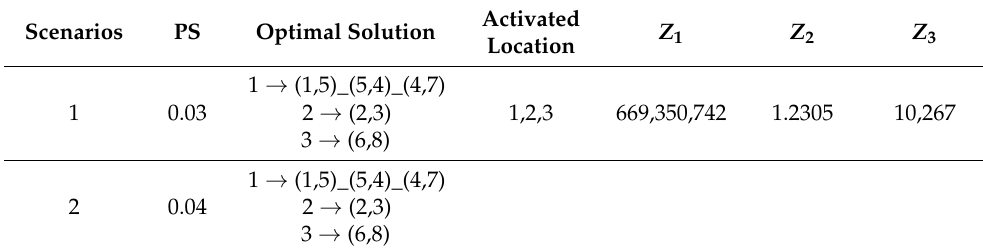
Table 9. Comparison of objective functions value in different scenarios.